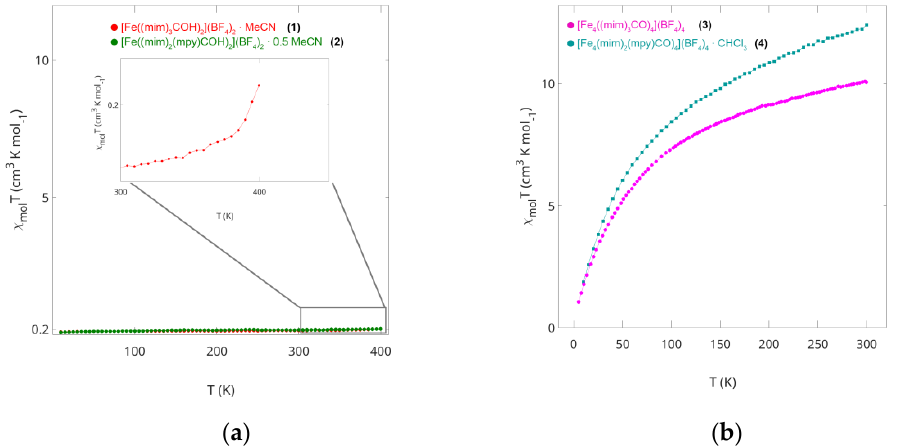
Figure 6. Temperature dependence of the magnetic susceptibility: ( a ) Mononuclear Compounds: red: Complex 1 , green: Complex 2 . ( b ) Tetranuclear Compounds: magenta: Complex 3 , cyan: Complex 4 . The temperature dependent change of the effective magnetic moment for the [Fe 4 O 4 ] clusters 3 and 4 shows a gradual decrease from 12.4 cm 3 K mol − 1 and 10.1 cm 3 K mol − 1 at